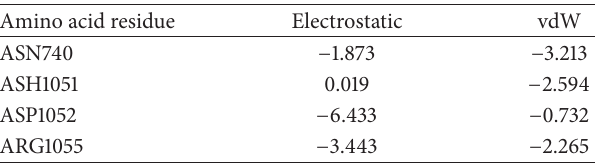
Table 2: Electrostatic interaction energy (kcal/mol) and vdW inter- actions between the Ethambutol and crucial amino acid involved in ligand